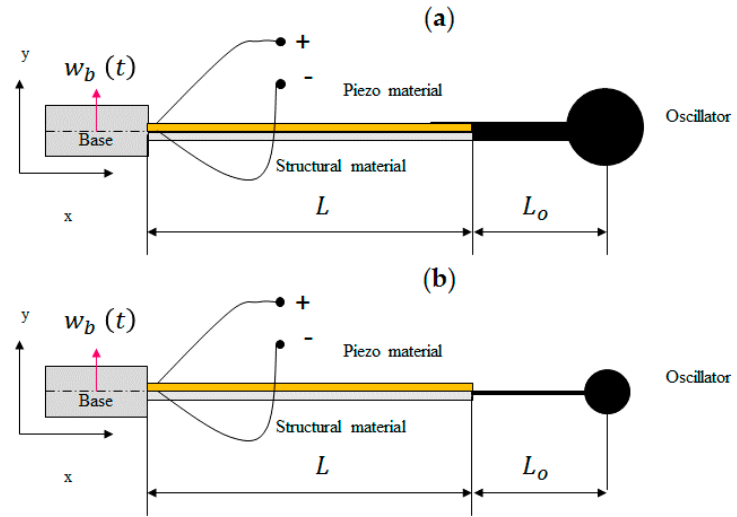
Figure 6. Scheme of the oscillators. ( a ) stiff high–mass oscillator A. ( b ) compliant low–mass oscillator B. Table 2. Characteristics of oscillators.